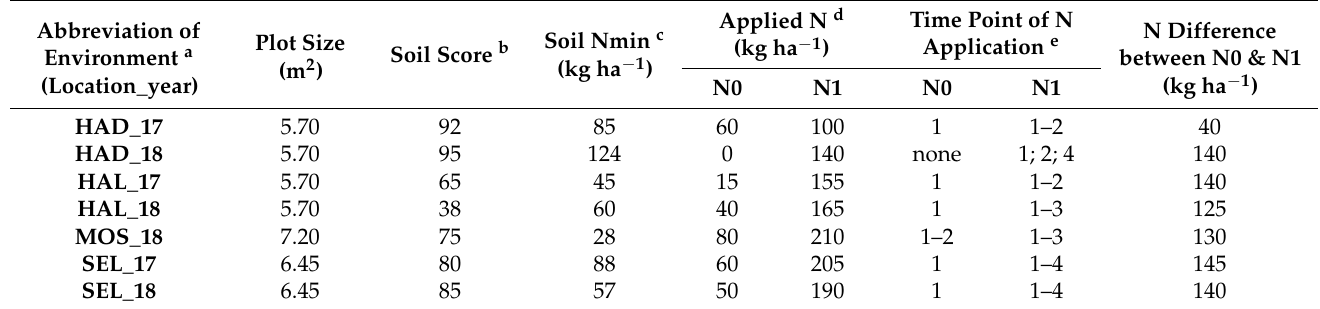
Table 4. Conditions of WM-800 field trials carried out in seven